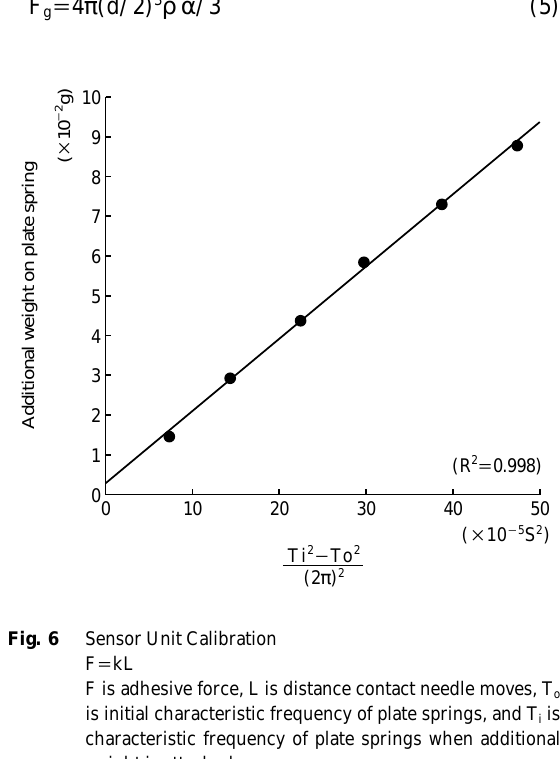
Fig. 6 Sensor Unit Calibration F (cid:2) kL F is adhesive force, L is distance contact needle moves, T o is initial characteristic frequency of plate springs, and T i is characteristic frequency of plate springs when additional weight is